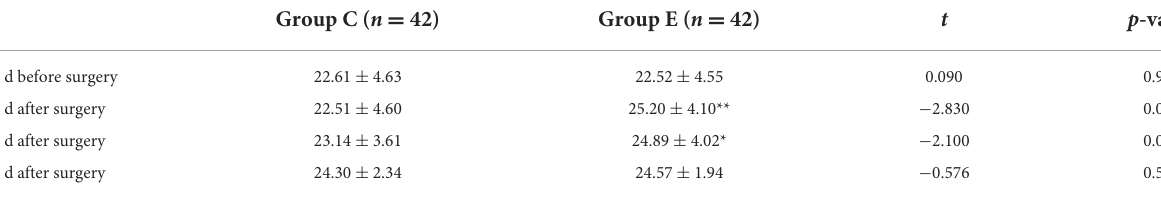
TABLE 5 Comparison of the score of MMSE.